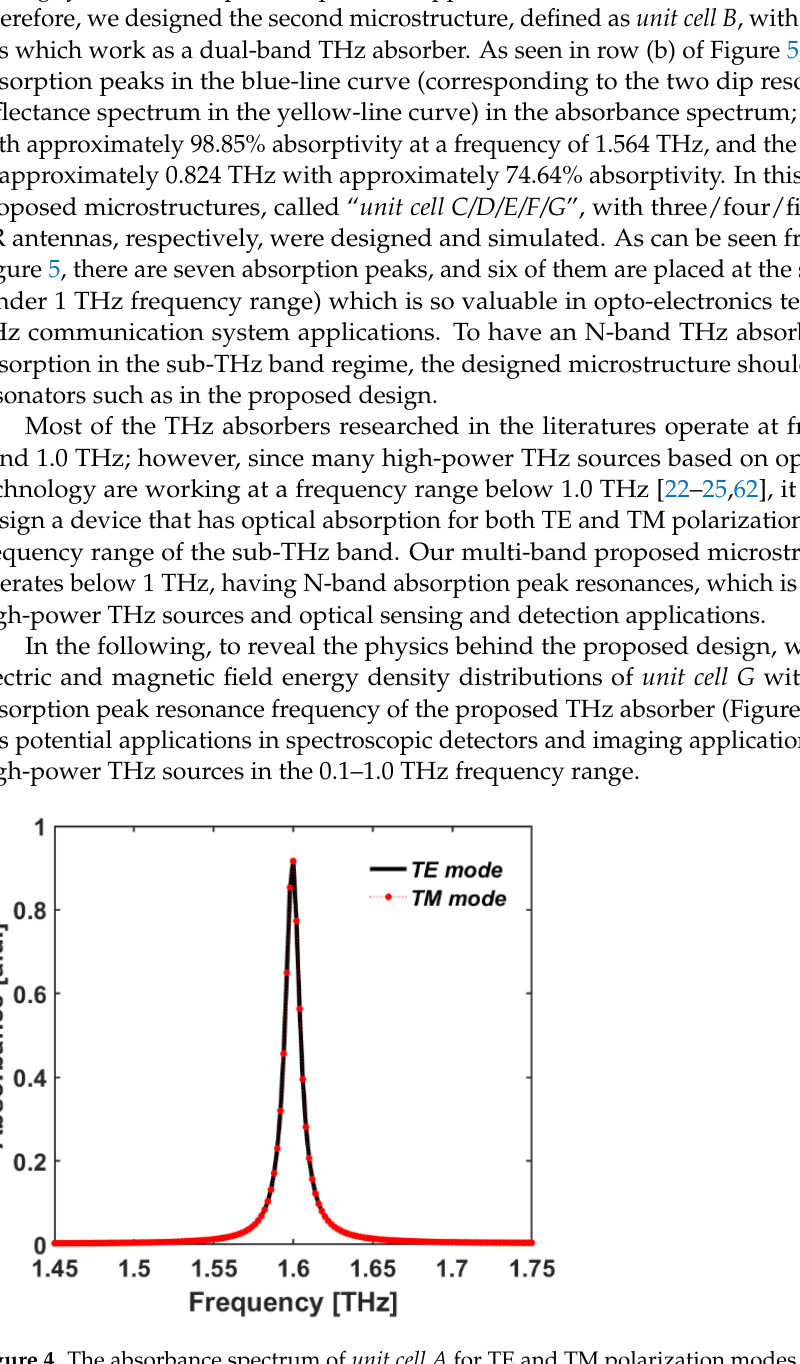
Figure 4. The absorbance spectrum of unit cell A for TE and TM polarization modes vs 202 frequency. 203